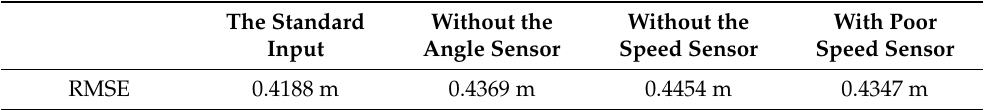
Table 3. The tracking performance with different